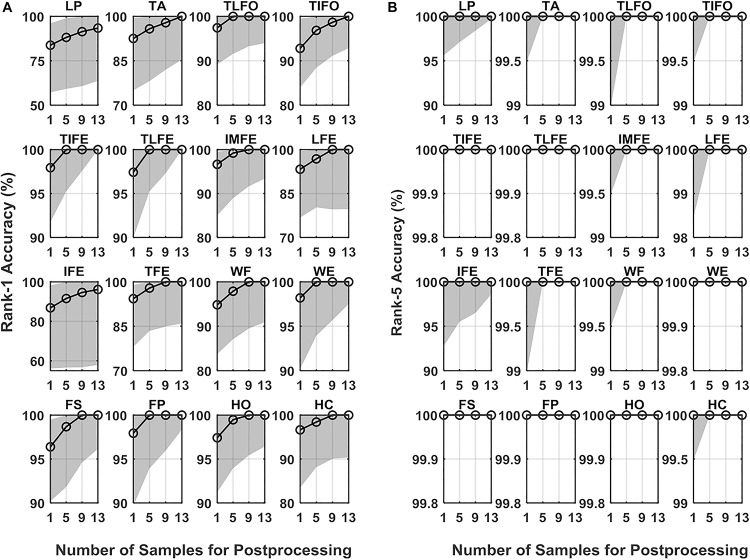
Identification performance measured in (A) Rank-1 and (B) Rank-5 for the 16 gestures, LP, TA, TLFO, TIFO, TIFE, TLFE, IMFE, LFE, IFE, TFE, WF, WE, FS, FP, HO, and HC, in three scenarios. The dot in each plot represents the median value of AUC, and the shaded area represents the range between the first quantile to the third quantile. The scales are different in each plot.